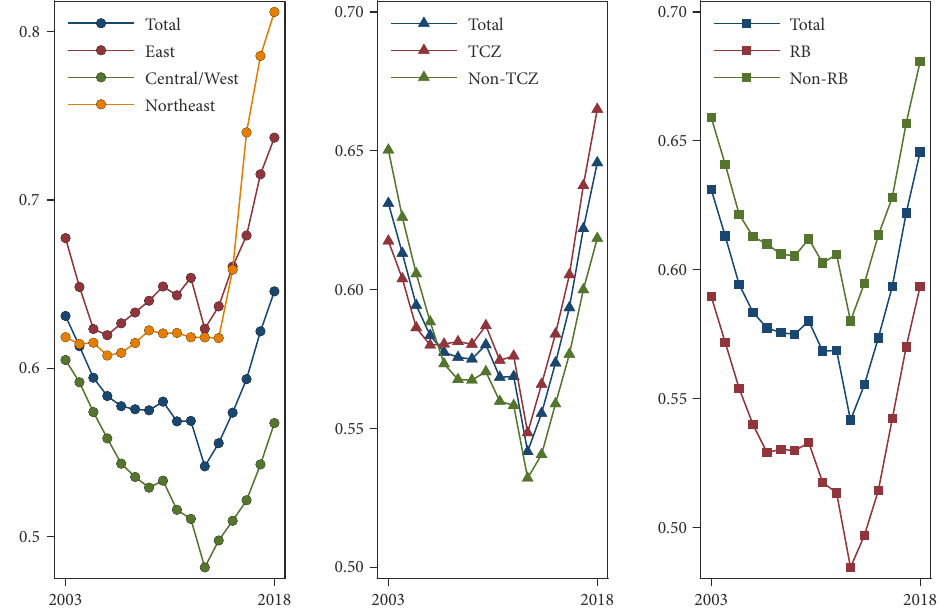
Figure 4 . Evolution of eco-efficiency for different